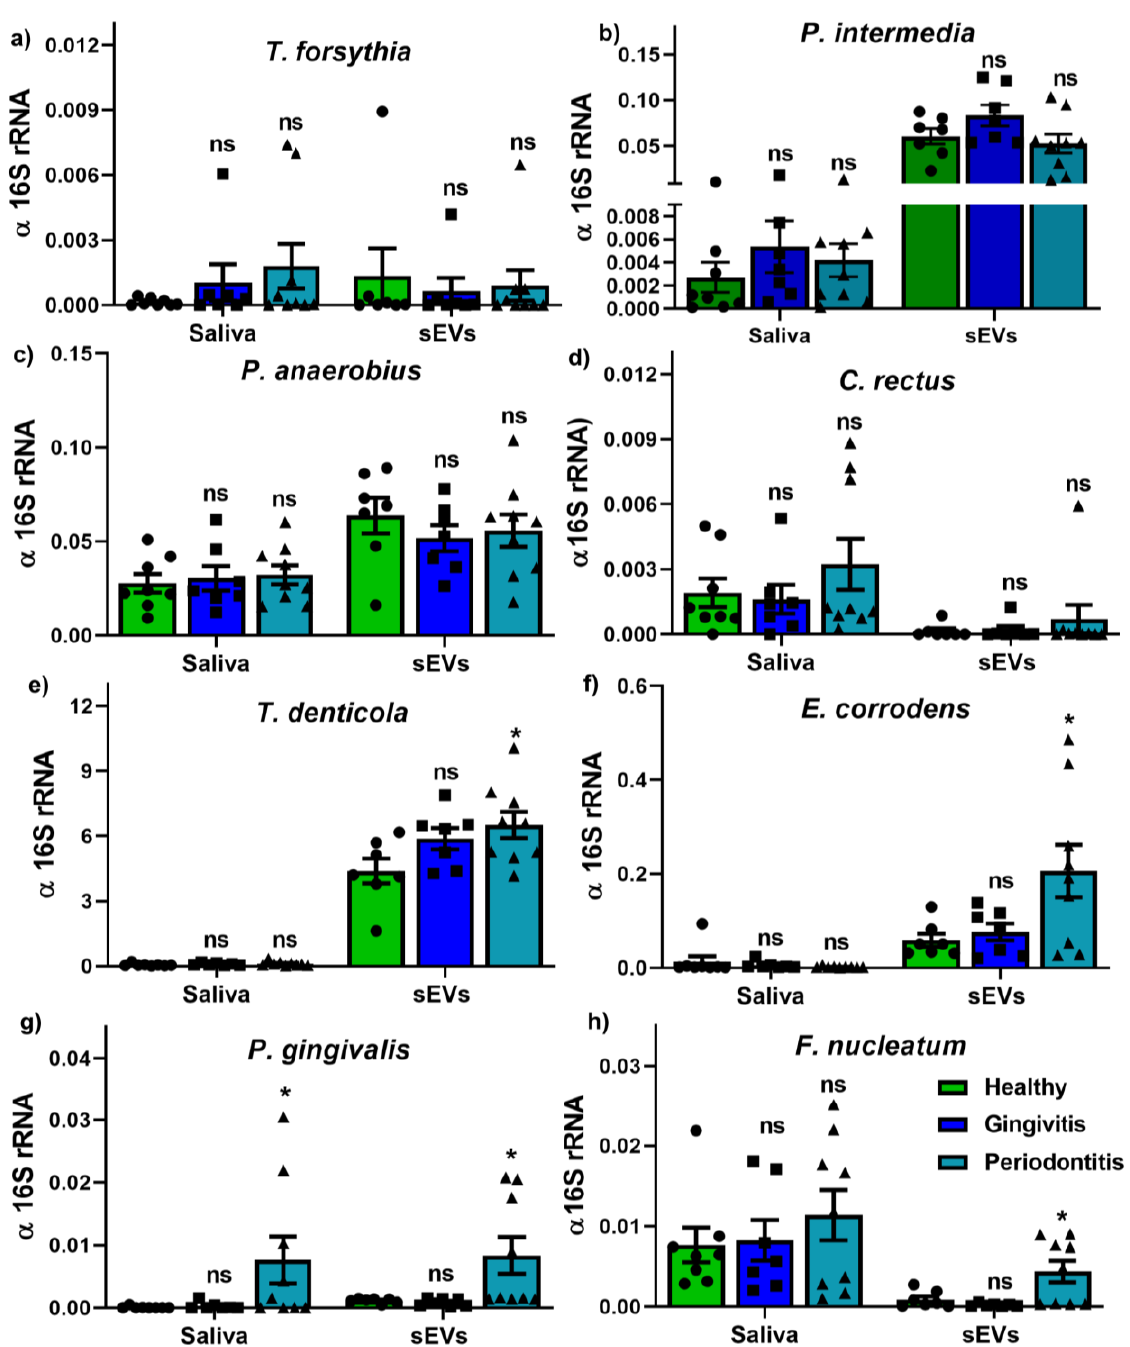
Figure 3. The detection of periodontal pathogens in saliva and salivary outer membrane vesicles (OMVs) within sEV population for eight Gram-negative putative periodontal pathogens ( a – h ). p values were calculated vs. healthy groups. *: p < 0.05.